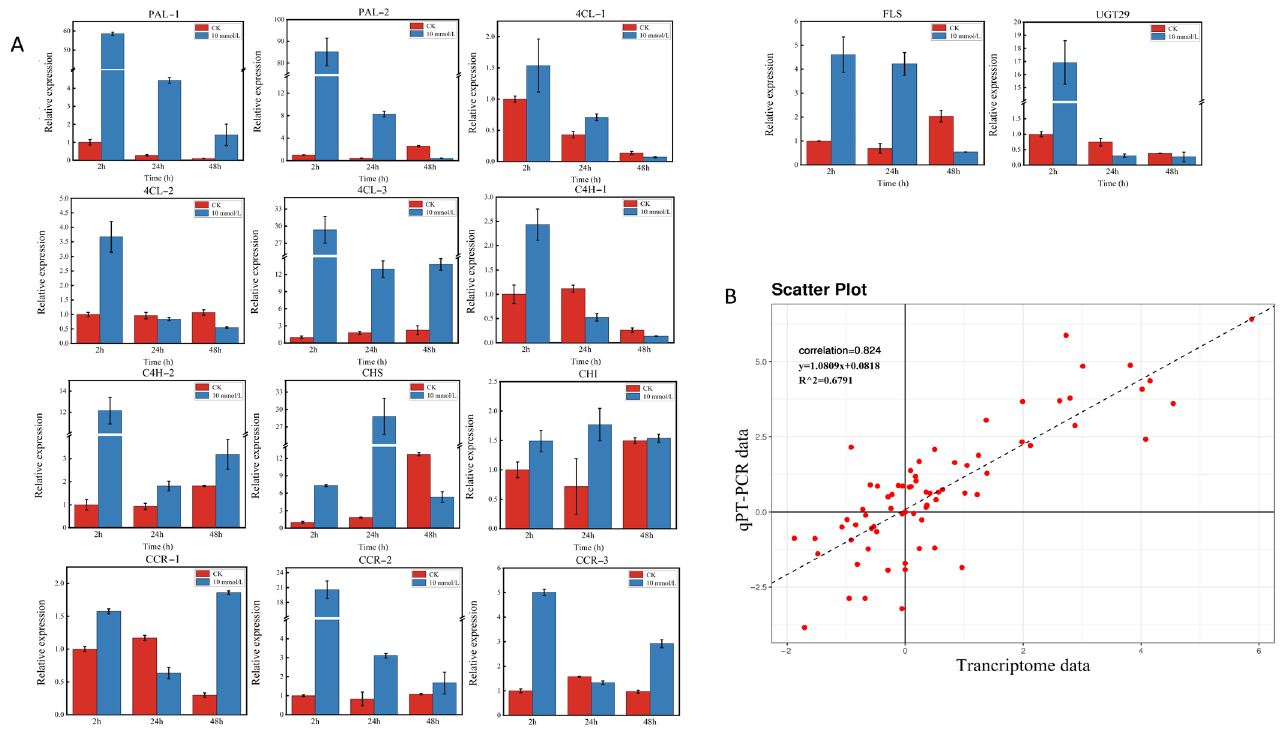
Figure 8. Expression pattern profiles of structural genes related to flavonoid biosynthesis. ( A ): The relative expression levels of the key structural genes in flavonoid biosynthesis pathways. ( B ): Scatter plot and linear regression based on qRT–PCR and transcriptome data. The correlation coefficient was calculated using the Spearman correlation method.